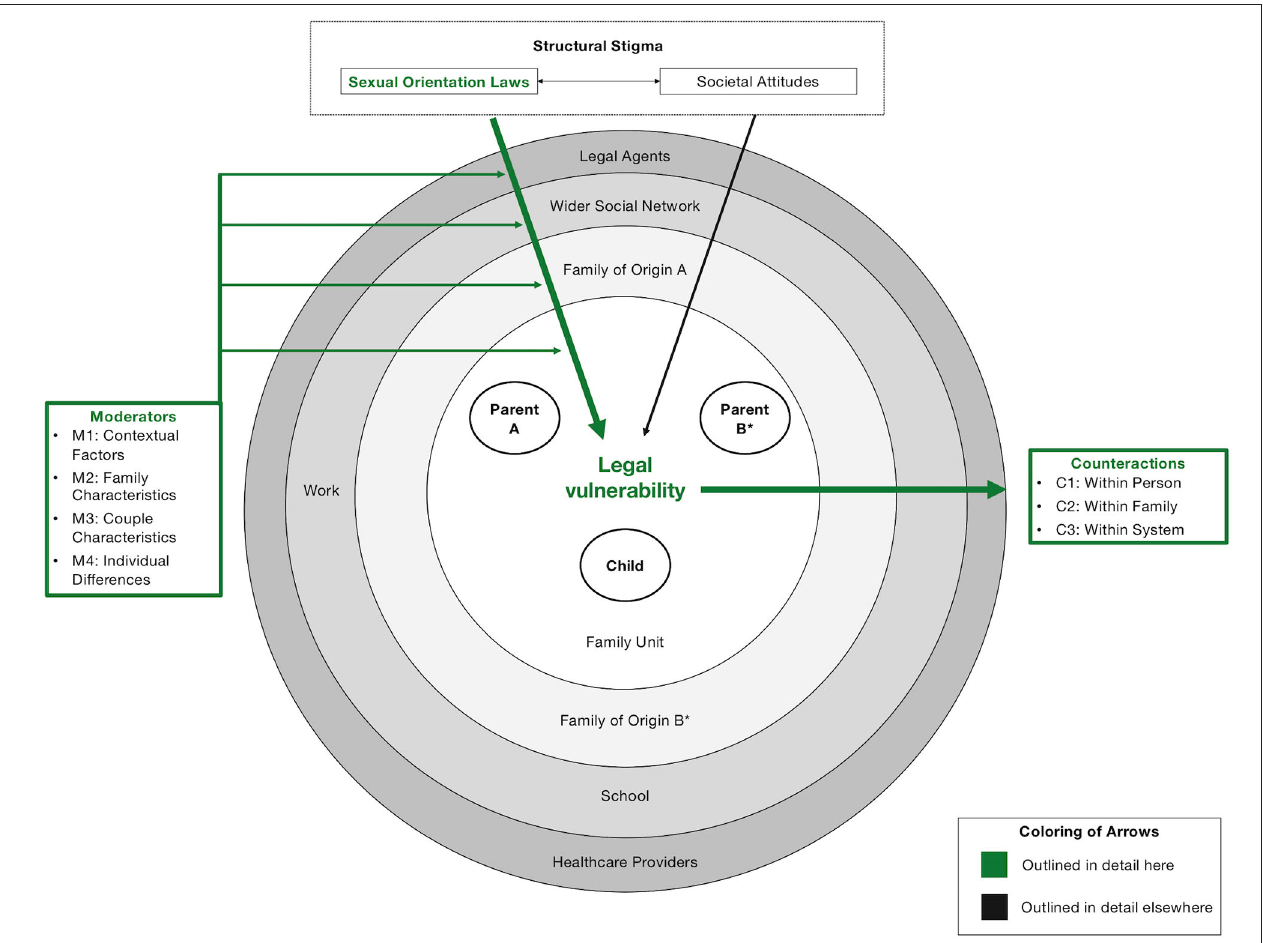
FIGURE 2 | The legal vulnerability model for same-sex parent families. Colored arrows (green) are outlined in detail here and depict empirically testable relations between constructs, not evidence strength. *Nonlegal status to (grand-)child and/or